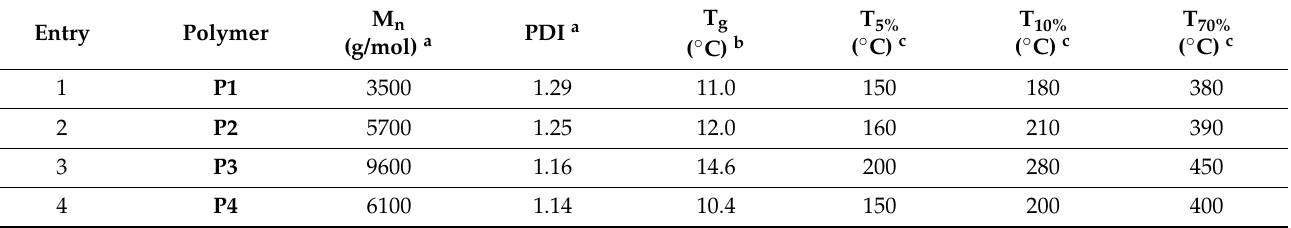
Table 4. Comparison of the properties of FPHUs and